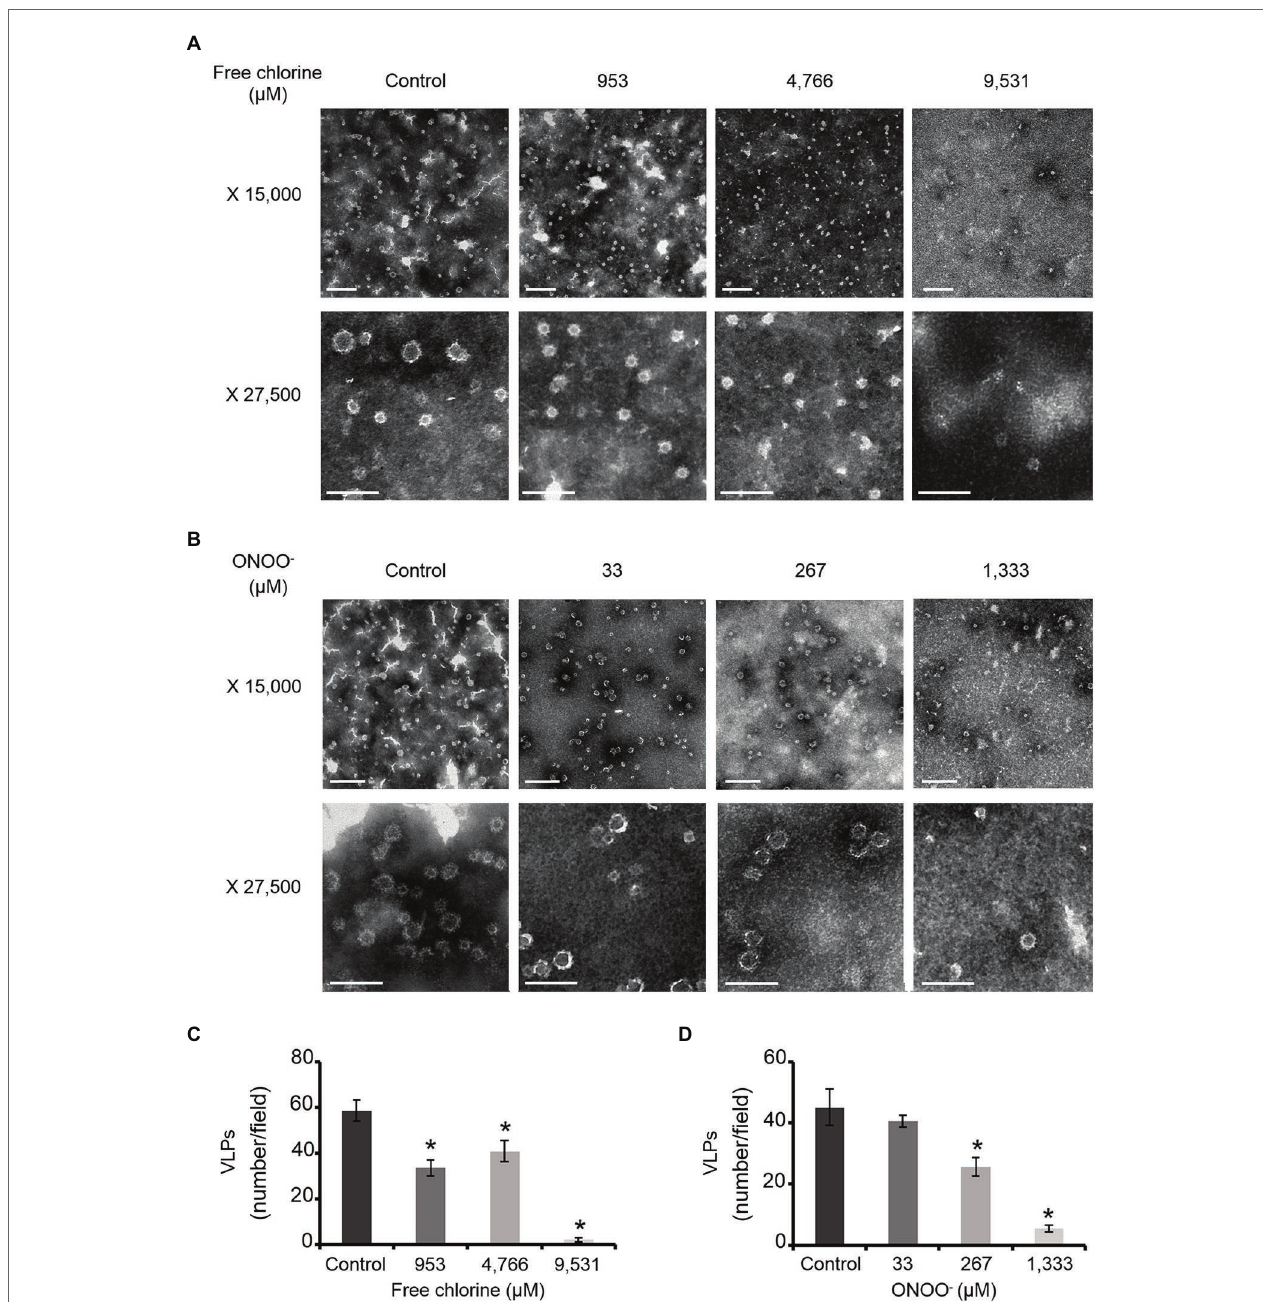
FIGURE 1 | Morphology of GII.4 VLPs after oxidative treatments. Images of GII.4 VLPs, both untreated and treated with free chlorine (A) and ONOO − (B) captured using TEM at X 15,000 (white scale bar at 0.2 μ m) and X 27,500 (white scale bar at 100 nm). Representative numbers of GII.4 VLPs per field observed using TEM at X 15,000 are indicated for native and oxidized particles at different concentrations of free chlorine (C) and ONOO − (D) . The number of GII.4 VLPs was determined from eight representative fields, which were obtained from two independent experiments, conducted on different days. Error bars indicate standard deviations. *Unpaired Student’s t -test and Mann-Whitney U test were used to compare groups with p <